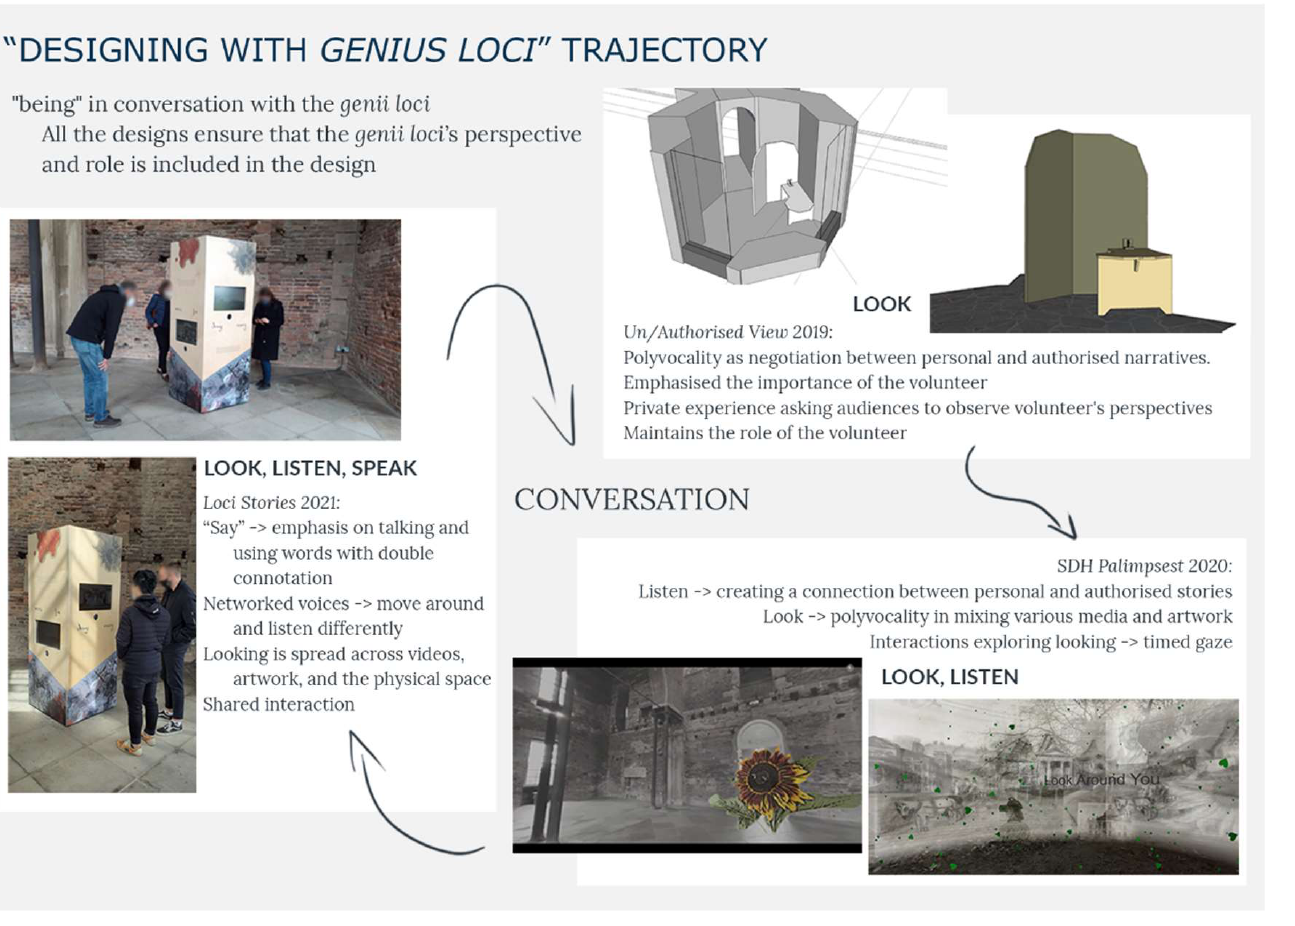
Figure 10. “Designing with Genius Loci ”—Design Trajectory of Conversation.